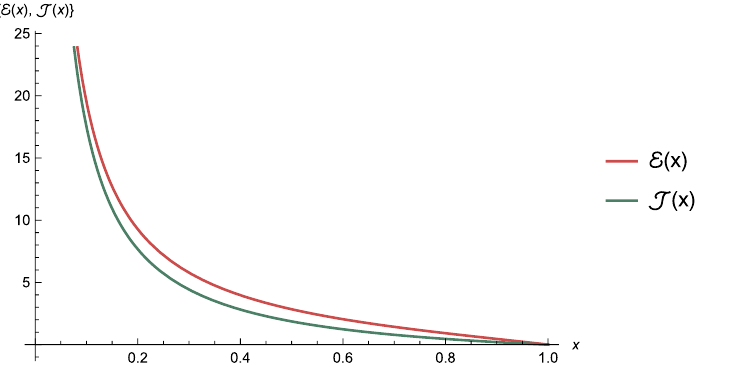
Figure 2. The energy E ( x ) and angular momentum J ( x ) of the spiky string for (cid:12)xed u 0